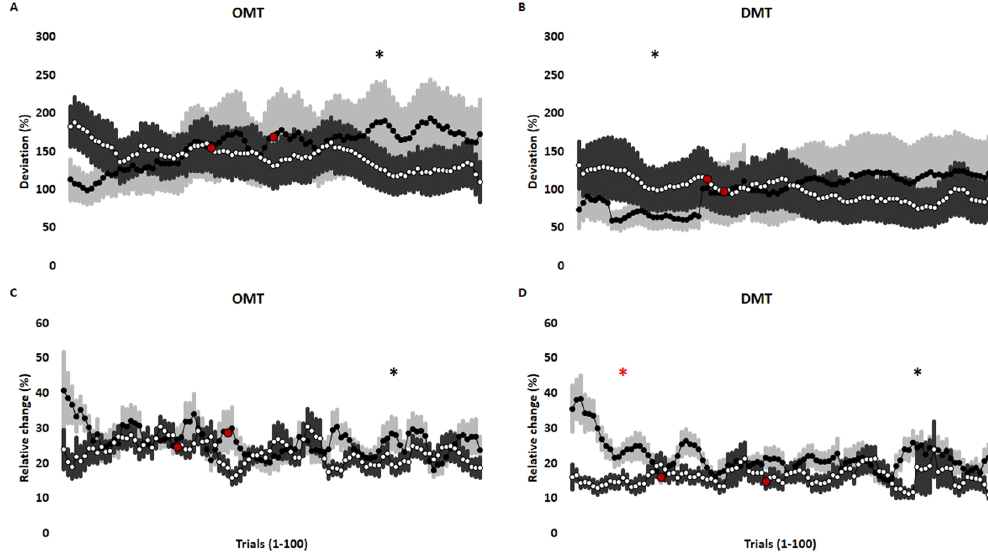
Figure 5. Mean and standard error of mean representing the dynamics of accuracy ( A , B ) and precision ( C , D ) of ballistic forces during OMT ( A , C ) and DMT ( B , D ) with low hold force (black circles) and high hold force (white circles). The data represents the average of the one hundred trials from eighteen participants across each session. A stepwise/segmented linear regression analysis was done to study the dynamics. The two slopes (viz. initial stage and final stage) of the regression lines were obtained from each participant during each session and each of the two slopes were compared to a flat line. The intersection of the two slope are demarcated by red circles. The black asterisks ( * ) denotes significant differences between the high hold force slope and the horizontal line. The red asterisks ( * ) denotes significant differences between the low hold force slope and the horizontal line.